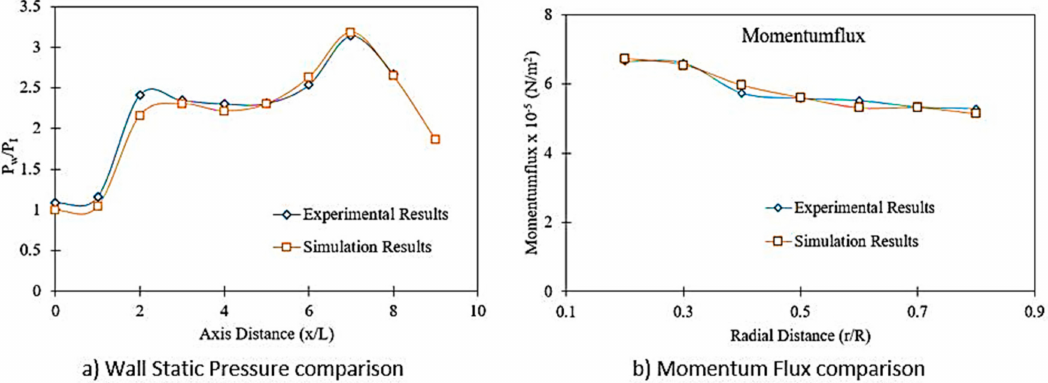
Figure 3. Validation of numerical results with experimental